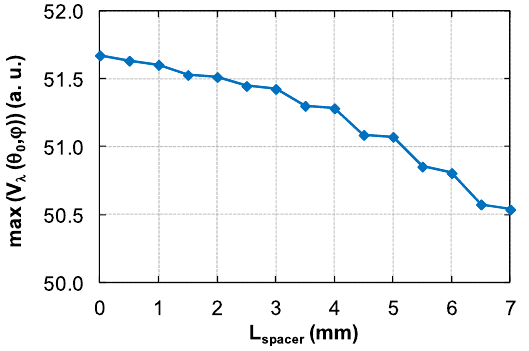
Figure 5. Maximum of spectral signals for different distance ring positions of transmittance